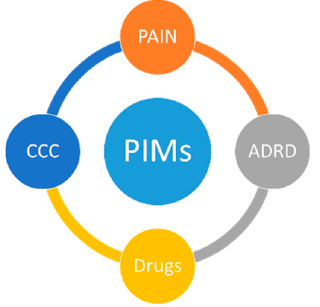
Figure 1. Relationship between dementia, pain, chronic complex conditions (CCC), polypharmacy and potential inap-propriate medication (PIM).